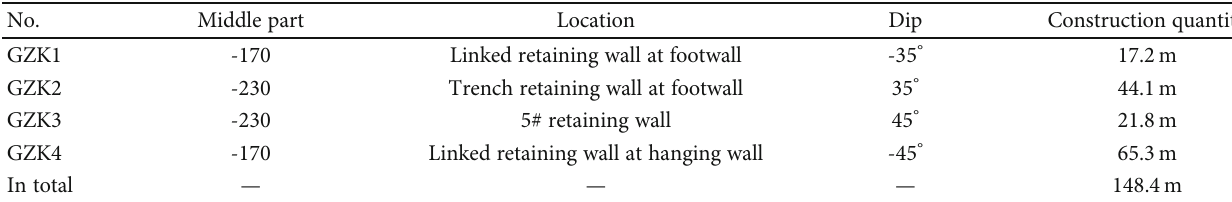
Figure 1: Cement tailing ratio in 17# room located at -230 m level. Table 1: Back fi ll drilling project